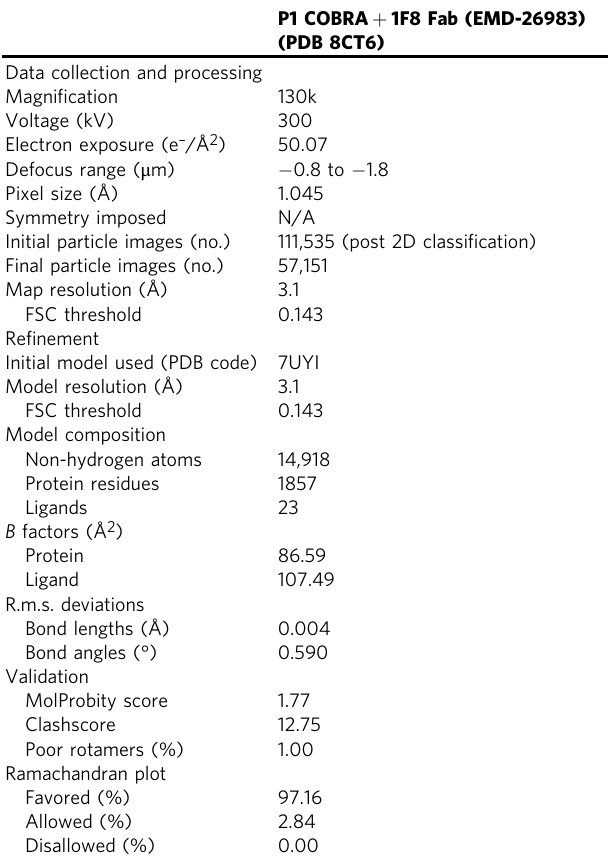
Table 2 Cryo-EM data collection, re fi nement and validation